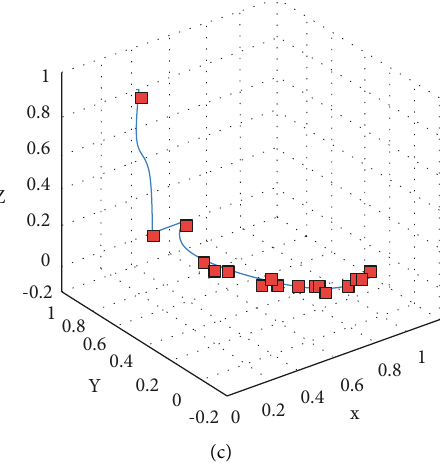
Figure 7: Competitive relationship trajectory of B ((a) 20 iterations; (b) 40 iterations; (c) 91